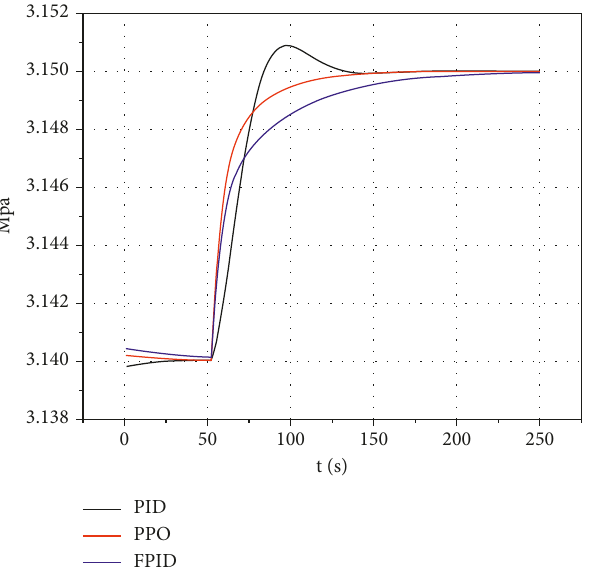
Figure 17: Simulation curve of steam pressure step up to 3.15 MPa.